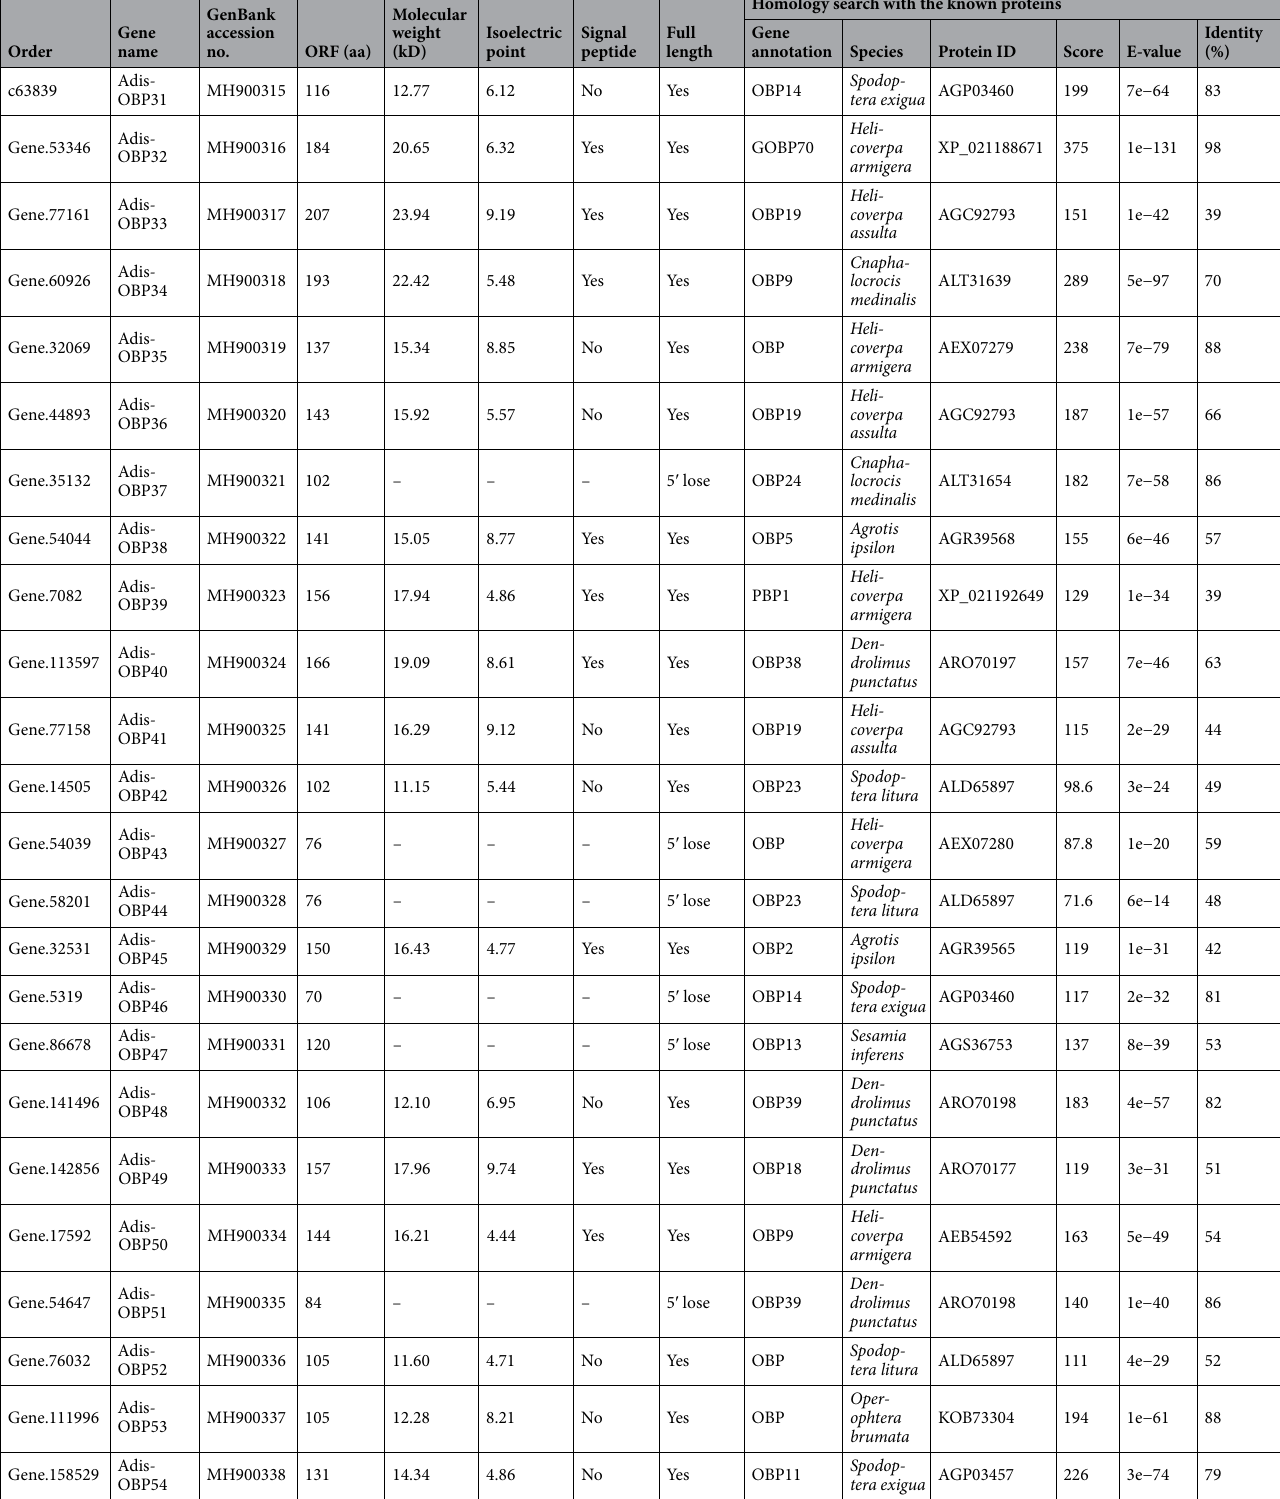
Table 4. The characteristic of candidate OBP genes in the antennae and reproductive organs of A. dissimilis . Genes beginning with the lowercase letter “c” came from the identification of antenna transcriptome, and genes beginning with “Gene” came from testis and ovary transcriptome